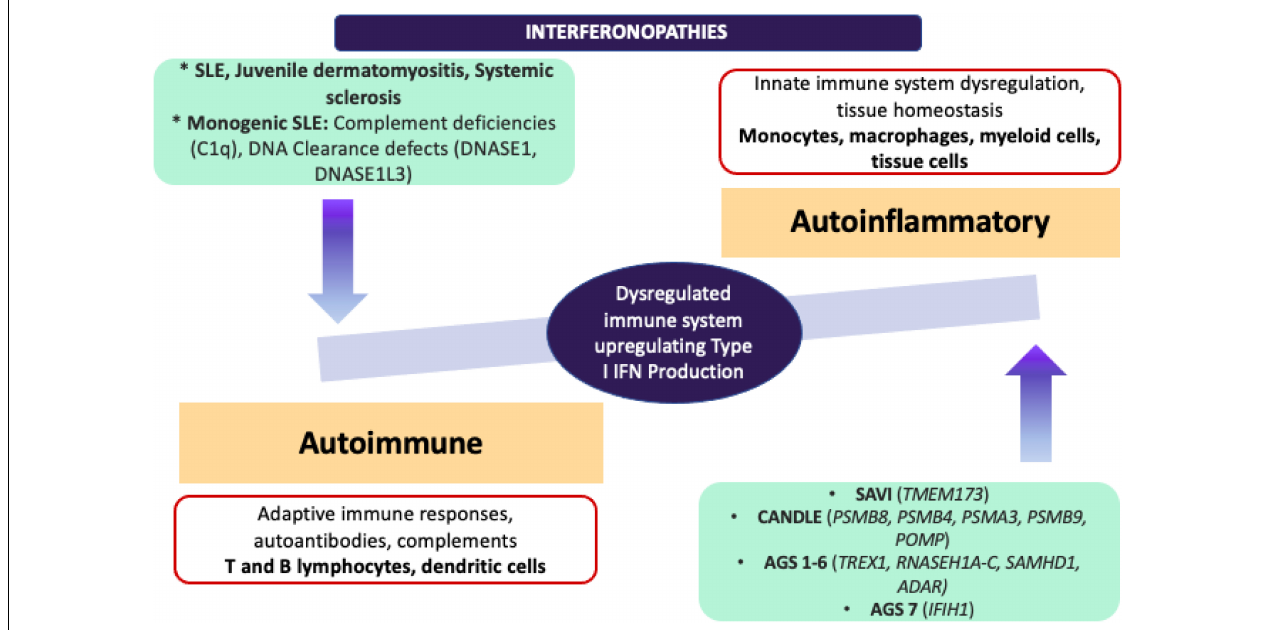
FIGURE 4 | Adapted from Kim et al. (68) comparison of autoinflammatory and autoimmune interferonopathies. Monogenic autoinflammatory interferonopathies that are demonstrated on the right end, are currently defined as CANDLE/PRAAS, SAVI and AGS, and driven by the mutations in proteasome complexes resulting in dysregulation in innate immune responses and increased transcription of IFN signature genes without immune complex deposition. On the left end, monogenic SLE, JDM and SSc are shown under autoimmune interferonopathies, since fundamentally adaptive immune system drives the underlying autoimmune pathology with production of autoantibodies, deposition of immune complexes and activation of T and B lymphocyte subsets. Pathogenic immune complexes can trigger IFN production in these conditions through activation of B lymphocytes and dendritic cells. ADAR, Adenosine deaminase RNA specific; AGS, Aicardi-Goutières Syndrome; CANDLE, Chronic Atypical Neutrophilic Dermatosis with Lipodystrophy and Elevated temperature; C1q, complement 1q; DNASE, deoxyribonuclease; IFIH1, Interferon induced with helicase C domain 1; IFN, interferon; JDM, juvenile dermatomyositis; POMP, Proteasome maturation protein; PSMA3, Proteasome 20S subunit alpha 3; PSMB 4/8/9, Proteasome 20S subunit beta 4/8/9; RNASE H1A-C, ribonuclease H1A-C; SAMHD1, SAM and HD domain containing deoxynucleoside triphosphate triphosphohydrolase 1; SLE, systemic lupus erythematosus; TMEM173, transmembrane protein 173; TREX1, three prime repair exonuclease